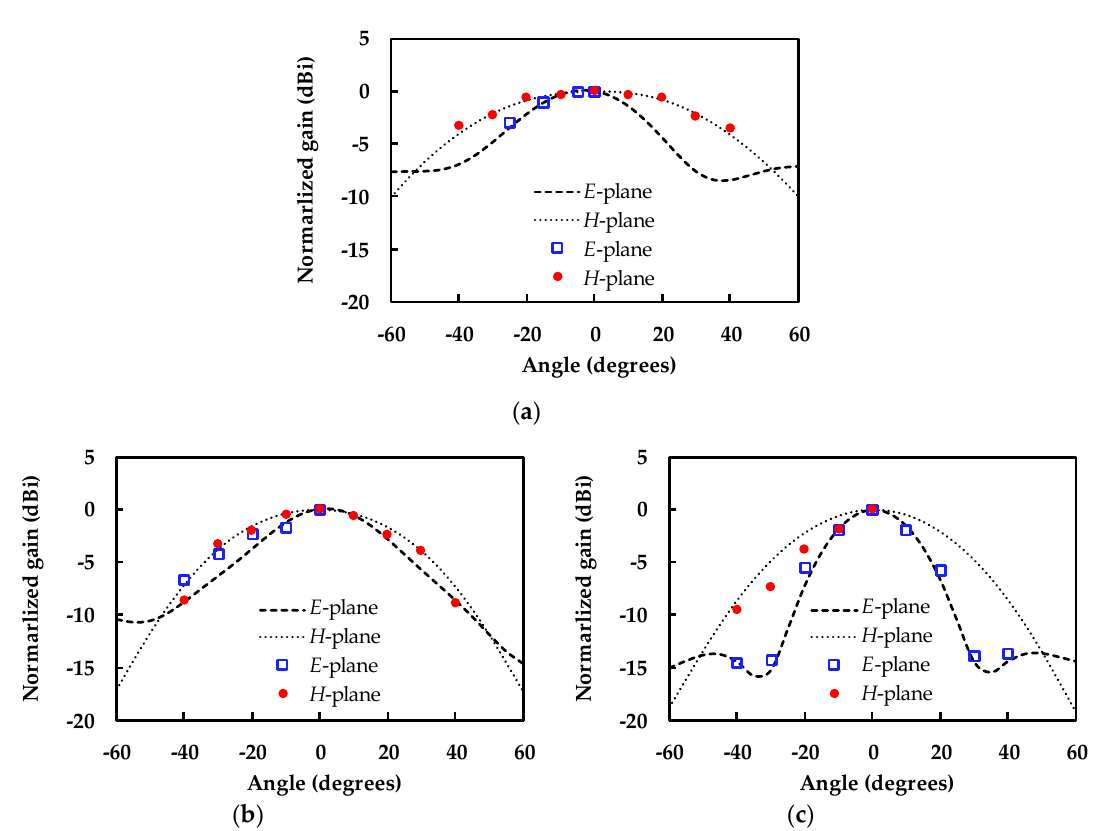
Figure 13. Simulation and measurement of radiation patterns at 300 GHz (lines: simulation, symbols: measurement). ( a ) Antenna element. ( b ) The 1 × 2 antenna array. ( c ) The 2 × 2 antenna array.